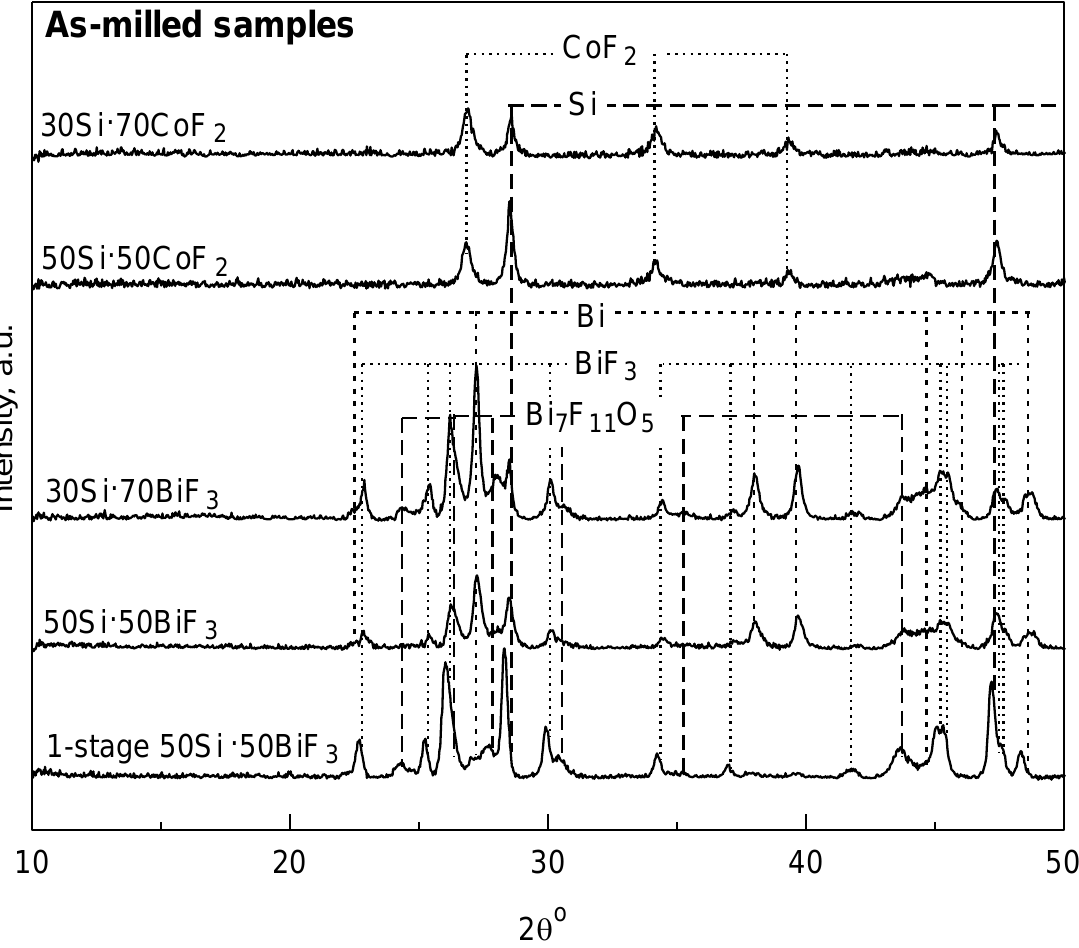
Figure 3. XRD patterns of the prepared composite powders. Table 3. Compositions of the prepared Si·BiF 3 composites obtained from the whole pattern refinement of the XRD traces.